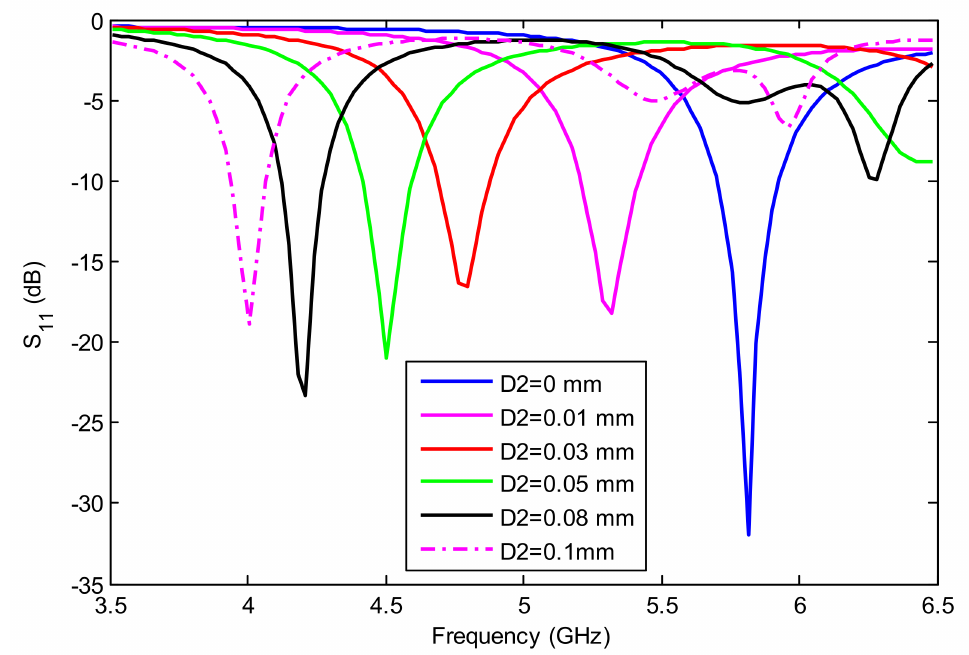
Figure 8. Thickness effects of the thin-film material on the return loss of the antenna.